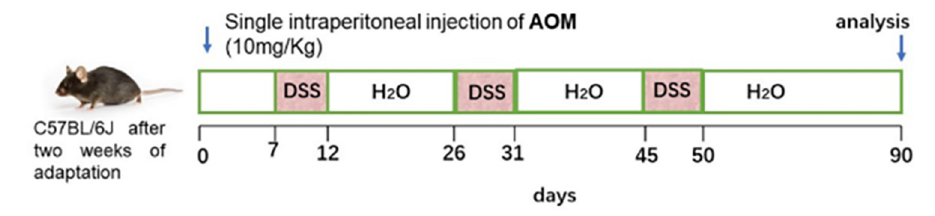
Fig 1. The mouse CRC model was induced using the azoxymethane/dextran sulfate sodium salt